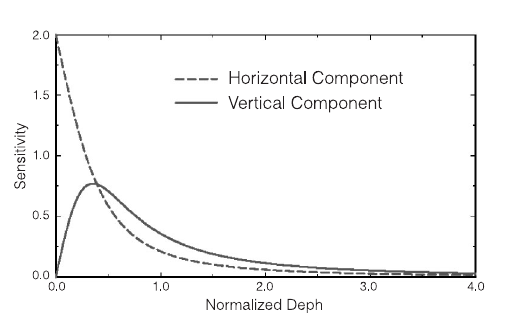
Fig. 2. Instrument sensitivity curves for the two dipole configurations. Horizontal mode configuration is more sensitive to contributions from materials at the very near subsurface while the vertical mode configuration better discriminates contributions at lower depth, with a maximum value at about 0.4 times the distance between the